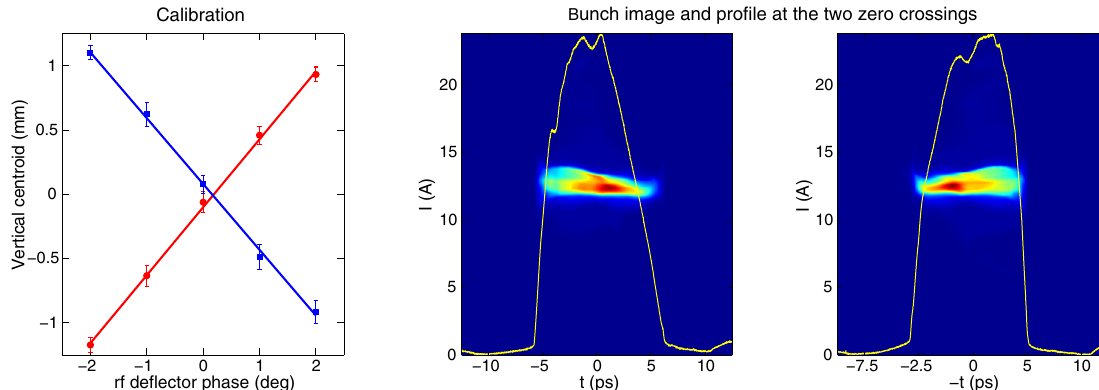
FIG. 58. Example of a bunch length measurement with uncompressed beam, showing the calibration measurement (left plot) and the current profiles overlaid on the images of the streaked beam, as observed at the two zero crossings of the rf deflector (right